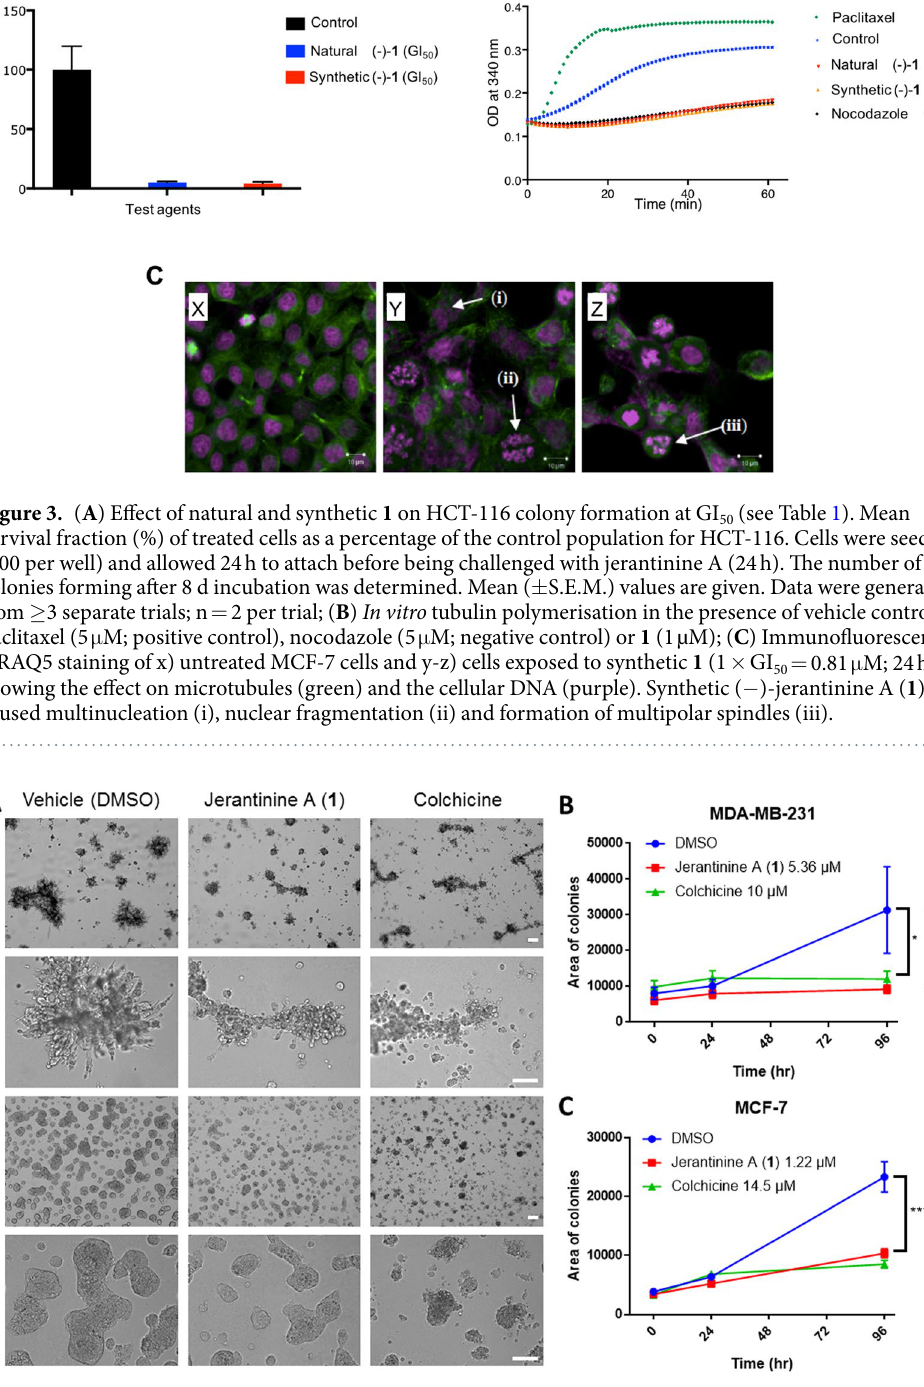
Soaking experiments with a selection of the jerantinine metabolites and derivatives into a crystal formed by a protein complex composed of two αβ -tubulin heterodimers, the stathmin-like protein RB3 and tubulin tyrosine ligase (T 2 R-TTL) 47,48 , yielded the tubulin-jerantinine B acetate ( 9 ) structure at 2.4 Å resolution (Fig. 5A;